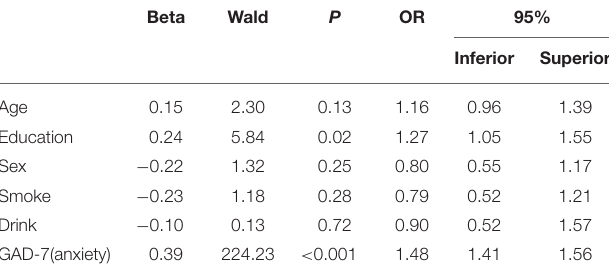
TABLE 8 | Influencing factors of insomnia in Nurse